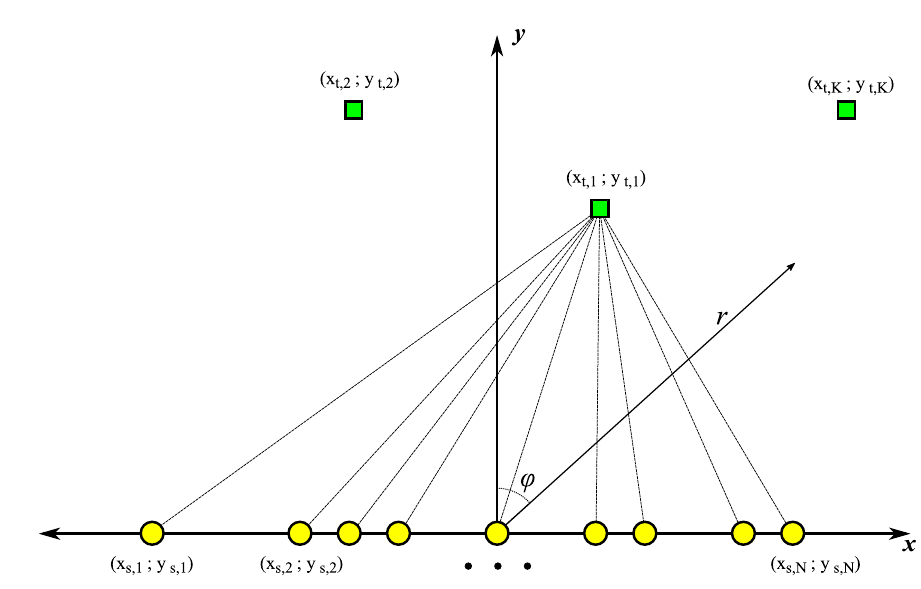
Figure 1. Massive MIMO system scenario. Circles: base station antennas; squares: